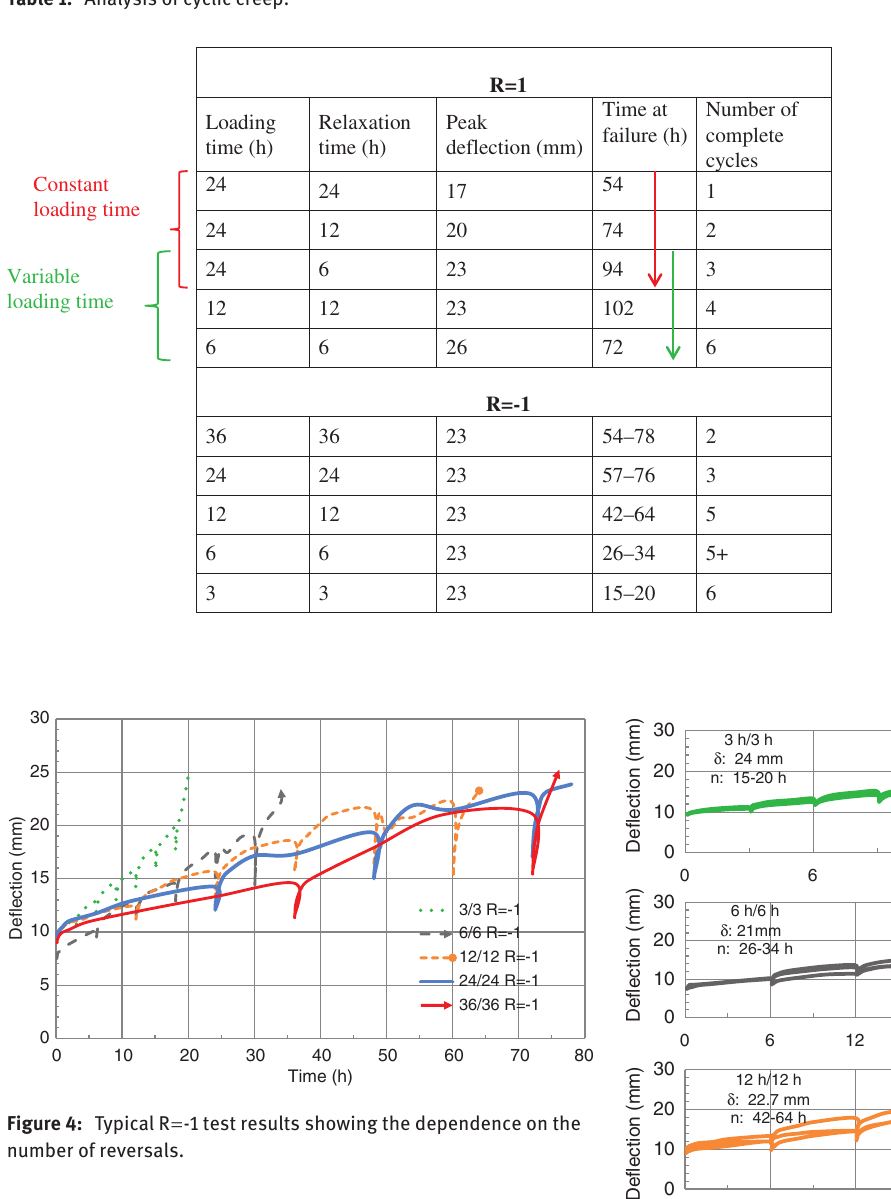
Table 1: Analysis of cyclic creep.